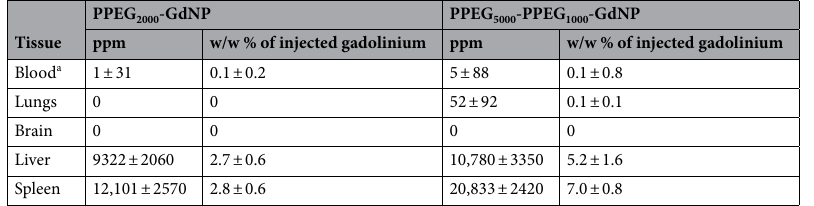
Table 1. Gadolinium content of mouse blood and clearance organs determined by ICP-MS. a Reported w/w% were rounded